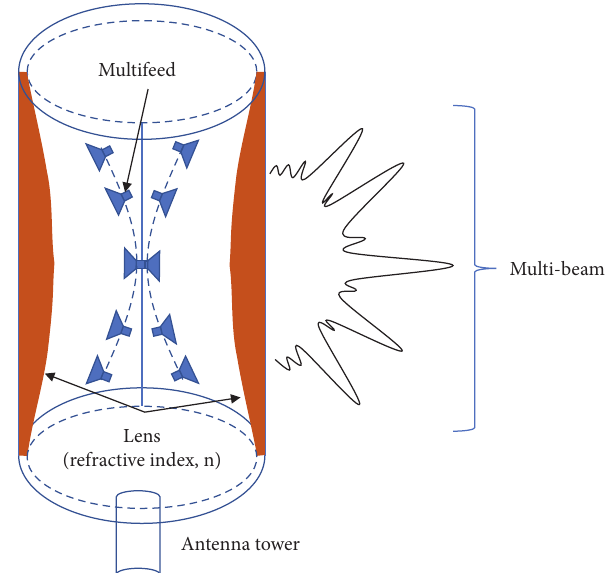
Figure 1: A multibeam lens antenna model for the base